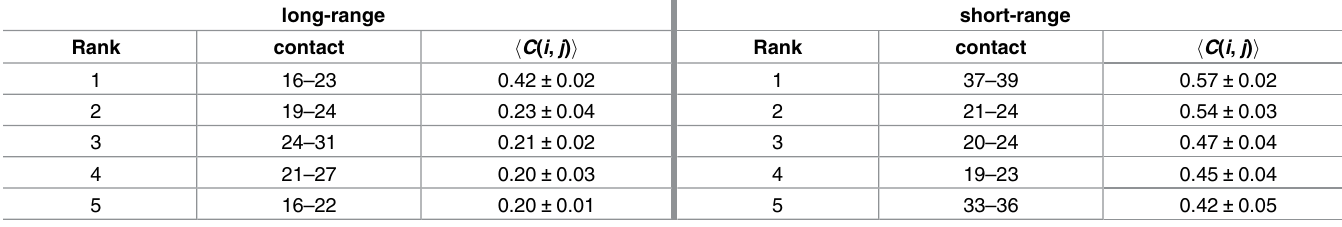
Table 5. Five top side chain contacts in A β 10-40peptide for C22cmapforce field a